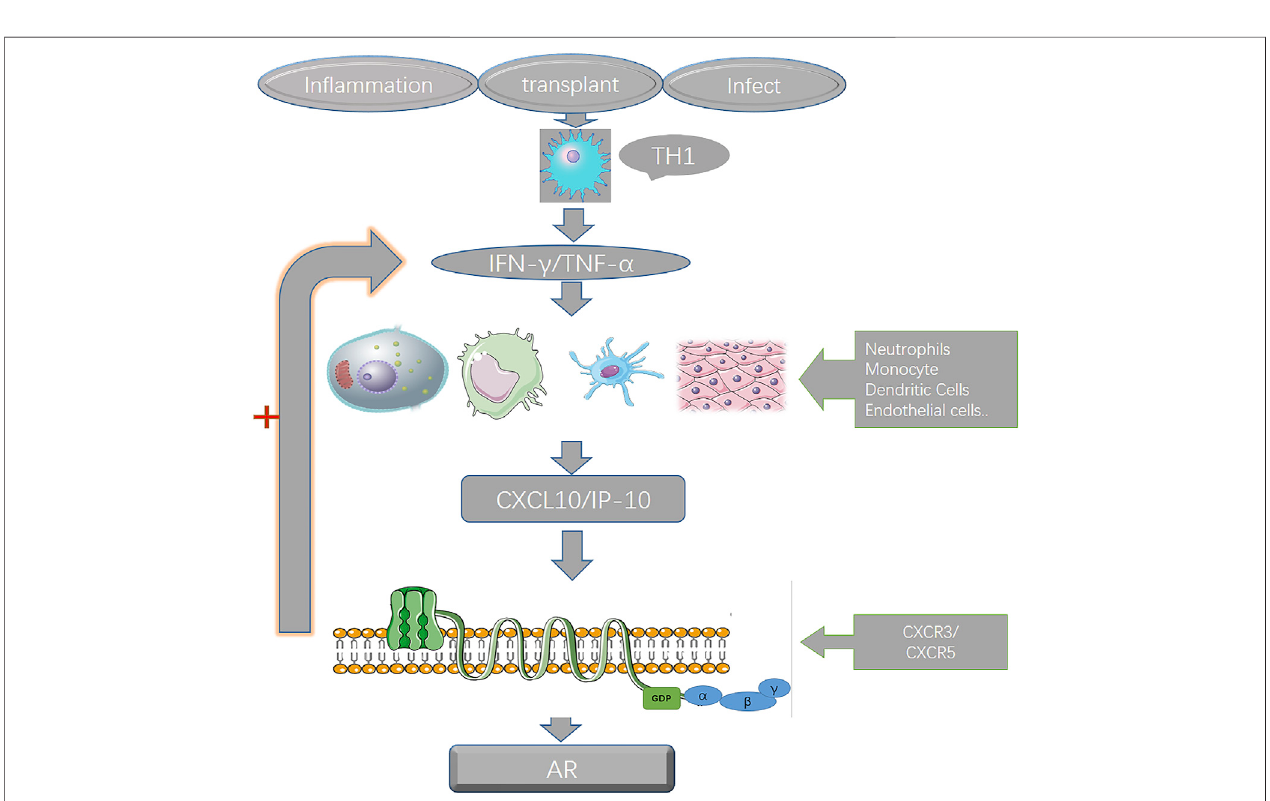
FIGURE 4 | the interaction of the genes in the prediction model. After kidney transplantation, early in fl ammation recruits various immune cells, and the secreted CXCL10 combines with CXCR3 on various immune cells to induce the expression and secretion of IFN- γ , which in turn recruits more immune cells to gather. Then the in fl ammatory storm was aggravated, and there was a positive feedback effect of CXCL10 and IFN- γ during the whole process.